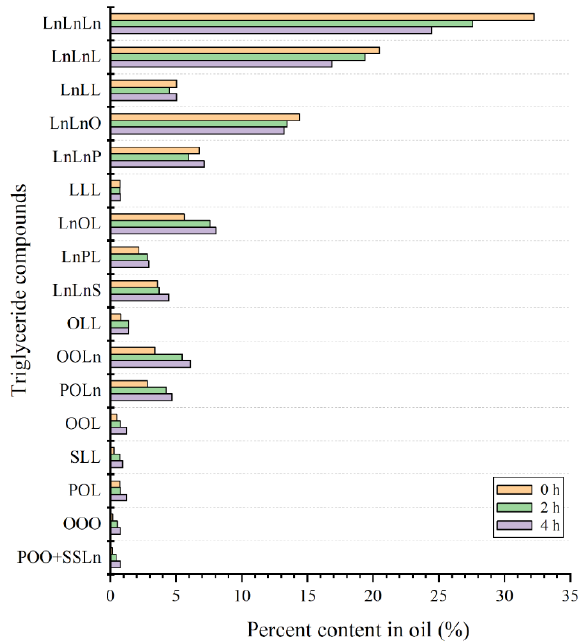
Figure 2. Changes of TAG composition of flaxseed oil during thermal-induced oxidation: P, Palmitic (C16:0); S, Stearic (C18:0); O, Oleic (C18:1); L, linoleic (C18:2); Ln, linolenic (C18:3).